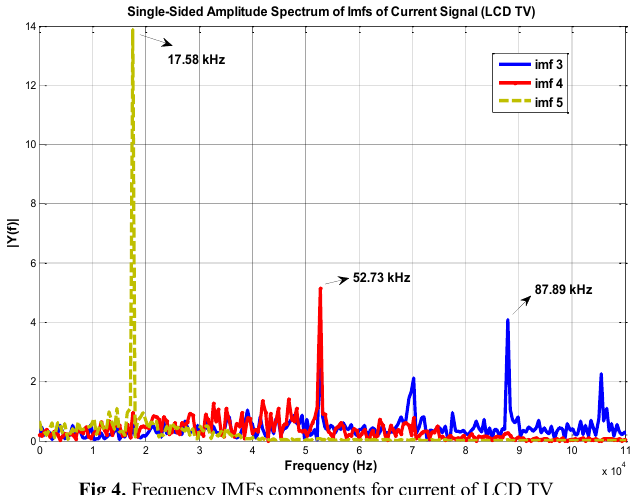
Fig 4. Frequency IMFs components for current of LCD